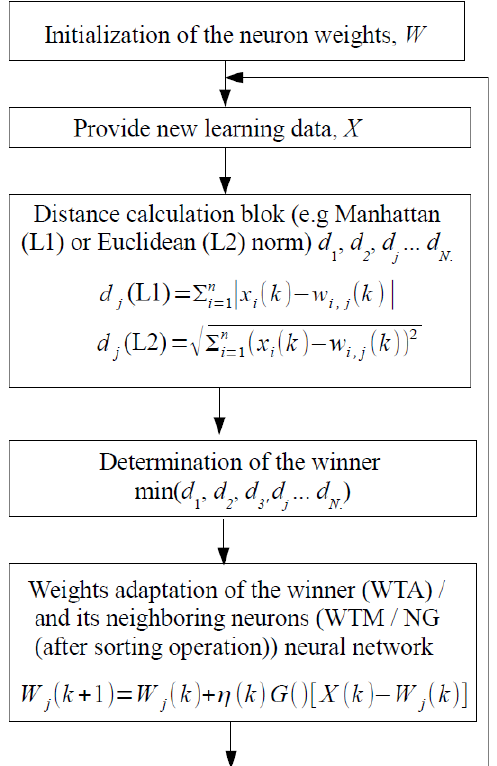
Figure 2. Diagram illustrating following steps of the learning algorithm of typical self-organizing neural